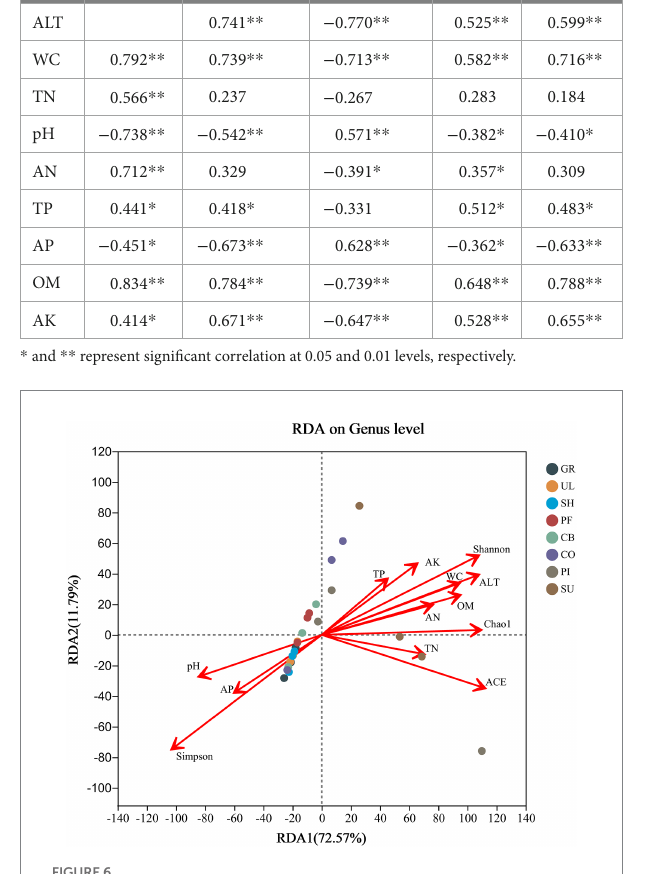
FIGURE 6 RDA between AMF diversity and physico-chemical properties of